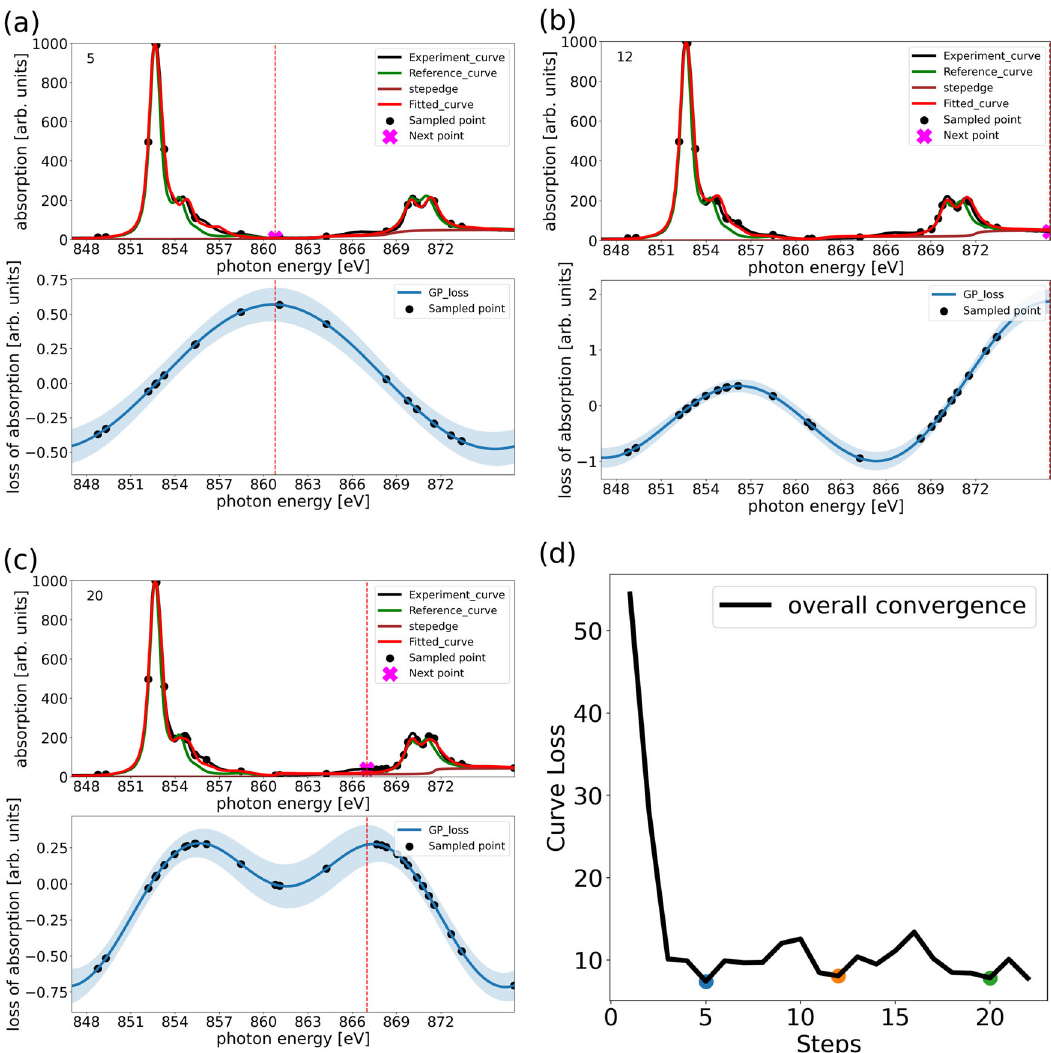
Fig. 5 The fi tting results of the experimental XAS with background fi tting. The fi tting results of the experimental XAS spectrum with background fi tting for different sampling points: a 17 sampling points (Step 5); b 24 sampling points (Step 12); c 32 sampling points (Step 20); d the convergence of the fi tted XAS curve in comparison to the experimental curve, with the colored dots denoting in order the results of Fig. 5a –